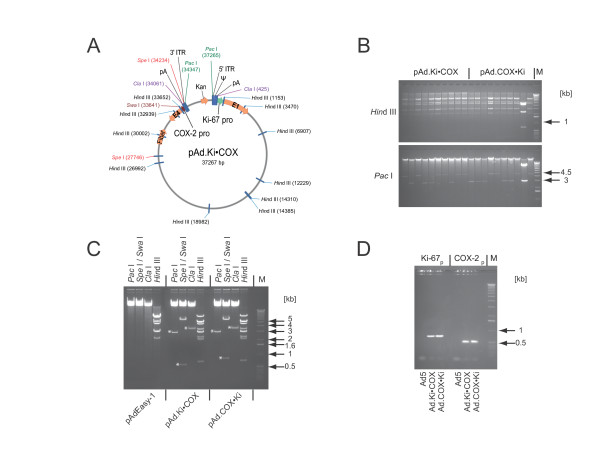
Cloning of oncolytic adenoviruses Ad.Ki•COX and Ad.COX•Ki. Panel A: The structure of the recombined adenoviral plasmid pAd.Ki•COX is shown. Restriction endonucleases used for analysis are mapped. For clarity, a map of pAd.COX•Ki, which is with the exception of the swapped promoters identical to pAd.Ki•COX, has been omitted. Panel B: BJ5183 cells pre-transformed with pAdEasy-1 were transformed with pShuttle#4 Ki•COX and pShuttle#4 COX•Ki. The integrity of the pAdEasy-1 plasmid in the pre-transformed E. coli was confirmed by Hind III digestion (data not shown). For each construct ten small scale DNA plasmid preparations of kanamycin resistant clones were digested with Hind III and Pac I and analyzed by electrophoresis through a 0.8% agarose gel and ethidium bromide staining. Panel C: High quality DNA was prepared by CsCl banding of potential valid recombinants and digested with Pac I, Spe I/Swa I, Cla I, and Hind III. The heterologous promoter driving the viral E4 region was flanked by Spe I and Swa I and the promoter controlling E1 by Cla I. The adenoviral backbone plasmid pAdEasy-1 served as a control. Diagnostic fragments obtained with each enzyme are marked with an asterisk (*). Panel D: Standard PCR was used to confirm on the rescued infectious recombinant adenoviruses Ad.Ki•COX and Ad.COX•Ki the presence of the Ki-67 and COX-2 promoter with the upstream polyA sequences in each virus. Ad5 served as negative control. The 1 kb DNA ladder from Invitrogen/Gibco was used as DNA size marker (M).